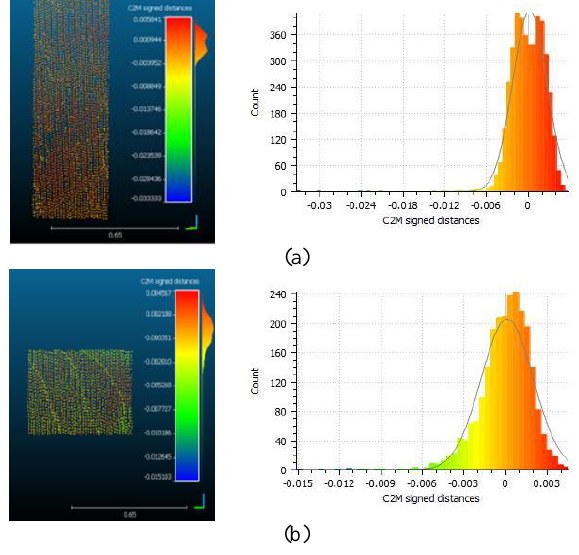
Figure 5: Plane fitting for two TLS subsets The laser scanner data has a high degree of planarity. Subset one has 4,245 points/unit area, and subset two has 2,372 points/unit area. For the same area, the point densities of the other data will be compared